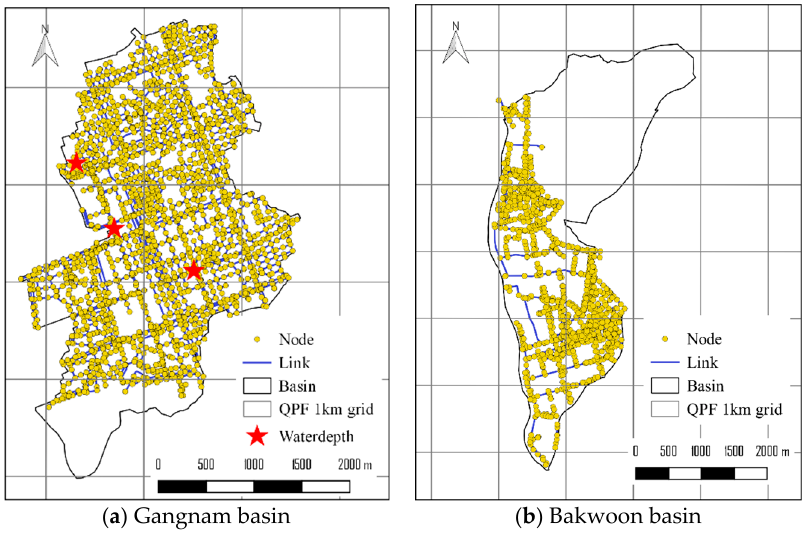
Figure 9. Drainage system used in Storm Water Management Model (SWMM) assessments of the ( a ) Gangnam basin and ( b ) Bakwoon basin (Section 3.3).